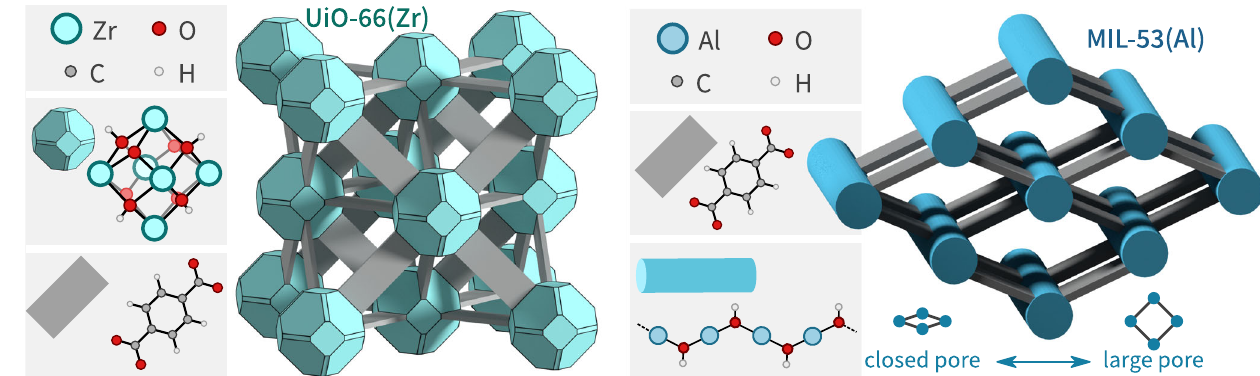
Fig. 1 Overview of the atomic structures of the frameworks. UiO-66(Zr) is a mechanically rigid framework with a single stable phase; MIL- 53(Al) is a fl exible